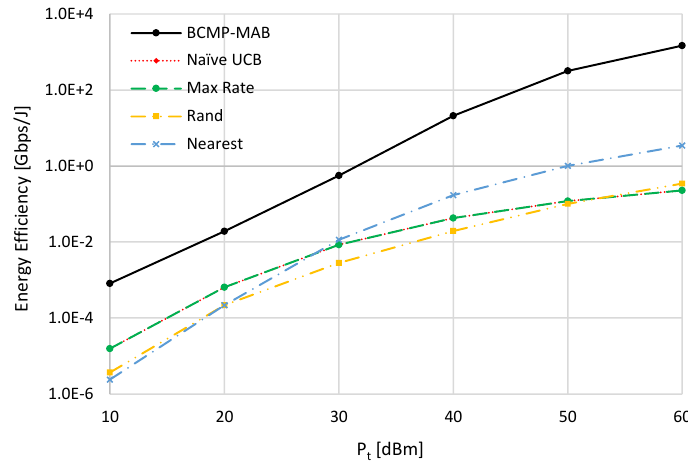
Figure 8. Average energy efficiency in bps/J against P t